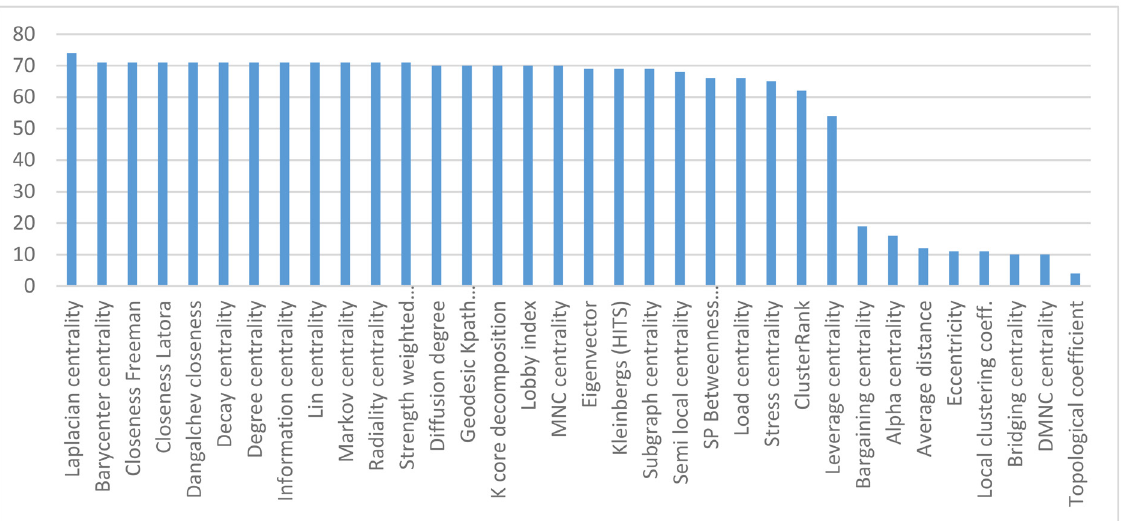
Fig 1. The percentage of essential proteins in the top 100 ranked proteins by various centrality indices.